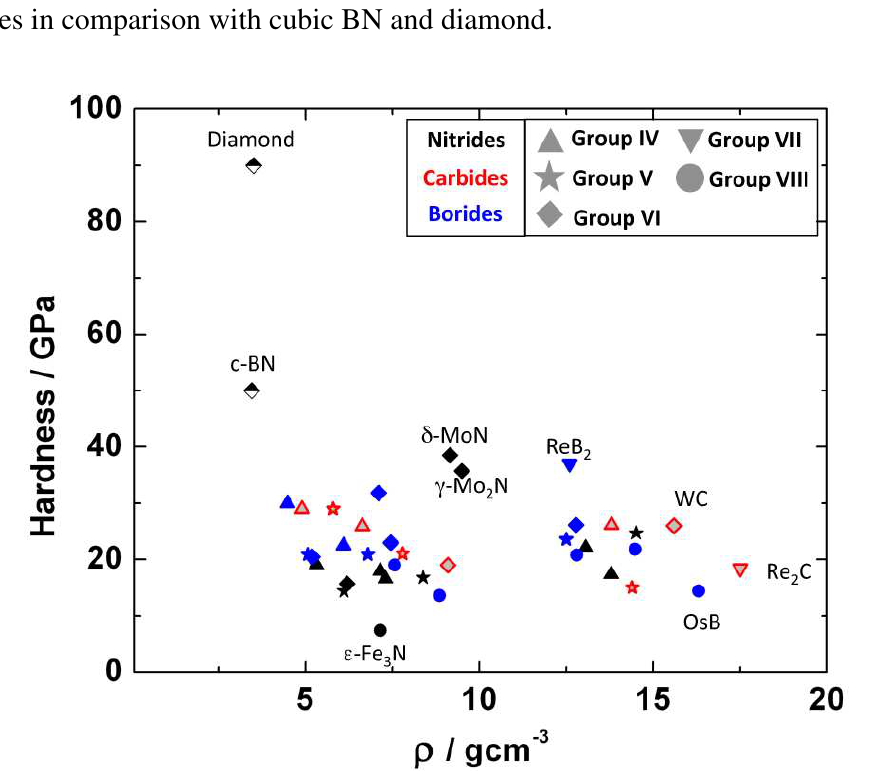
Figure 23. Plot of the hardness versus density of binary transition metal carbides, nitrides and borides in comparison with cubic BN and